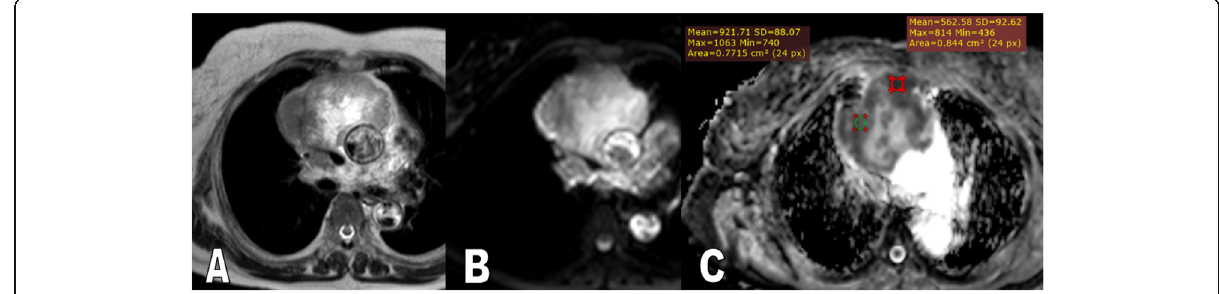
Fig. 7 Case of neuroendocrinal carcinoma. A 66-year-old female patient complaining of chest pain and weight loss. MRI chest ( a ) axial T2WI, ( b ) DWI, and ( c ) ADC map showing anterior mediastinal mass being hypointense on T2 WI, showing restricted diffusion (high signal on DWI and low signal on ADC map) with a mean ADC value of 0.92 × 10 − 3 mm 2